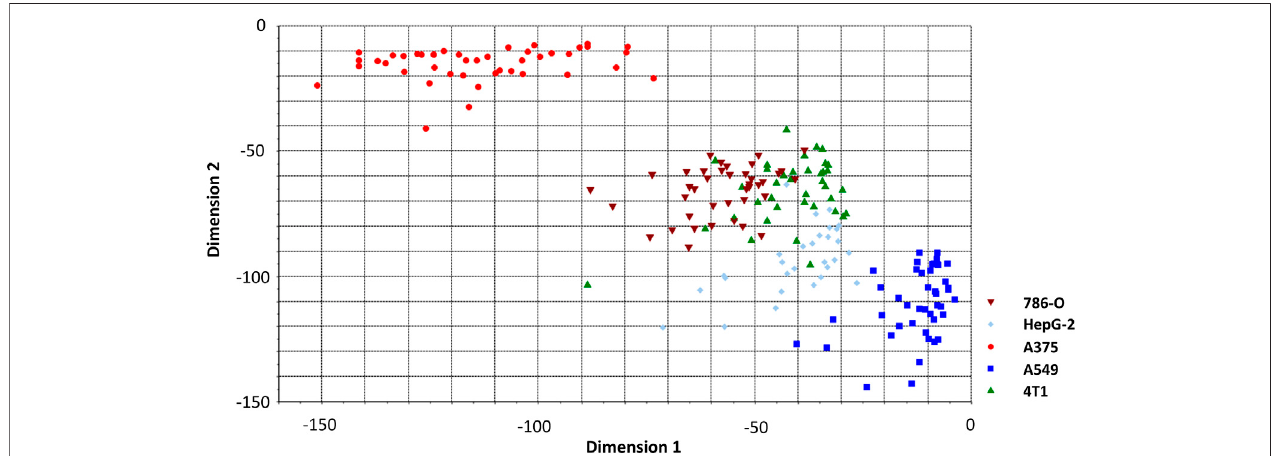
FIGURE 5 | LDA classi fi cation model classifying spectrum of cancer cell lines. Two of fi ve dimensions are plotted.